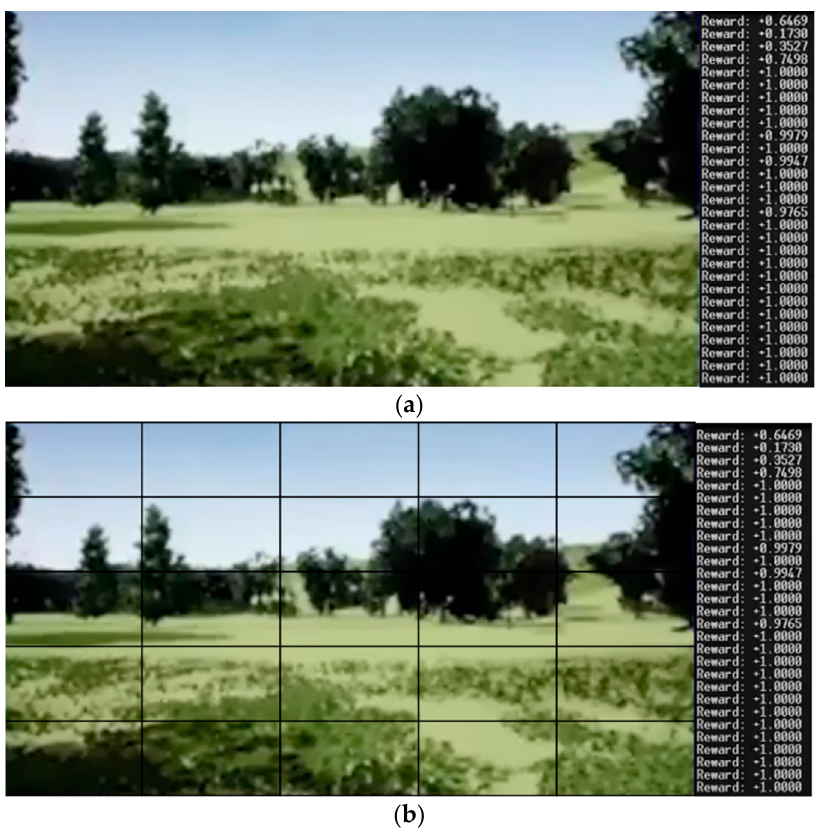
Figure 35. The first-person views of the drone and the rewards, next to: ( a ) the original RGB image, ( b ) the same image, divided into a 5 × 5 action space.